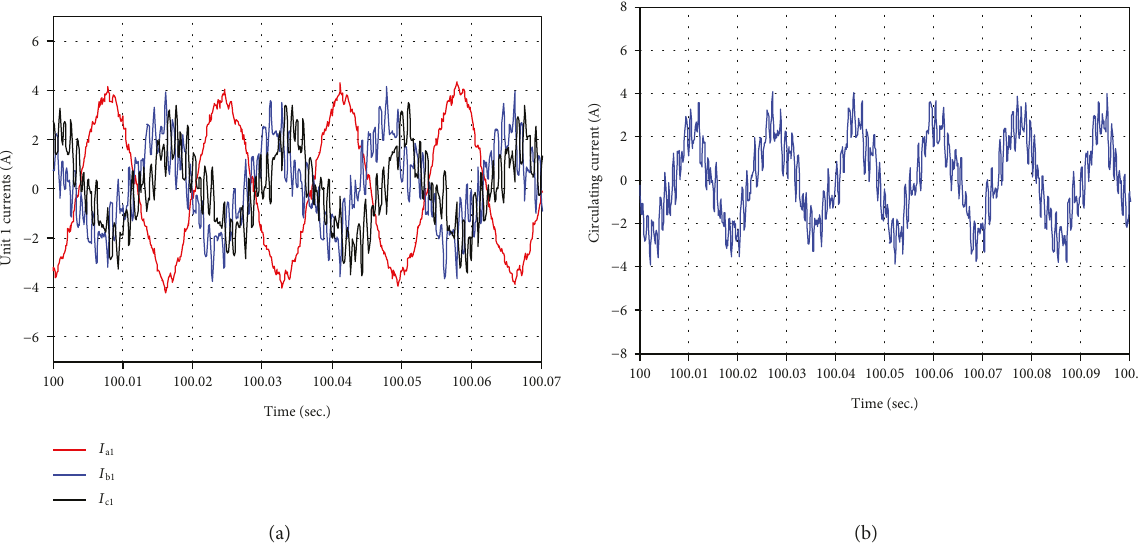
Figure 25: (a) The current inside unit 1 of con fi guration B. (b) The circulating current inside con fi guration